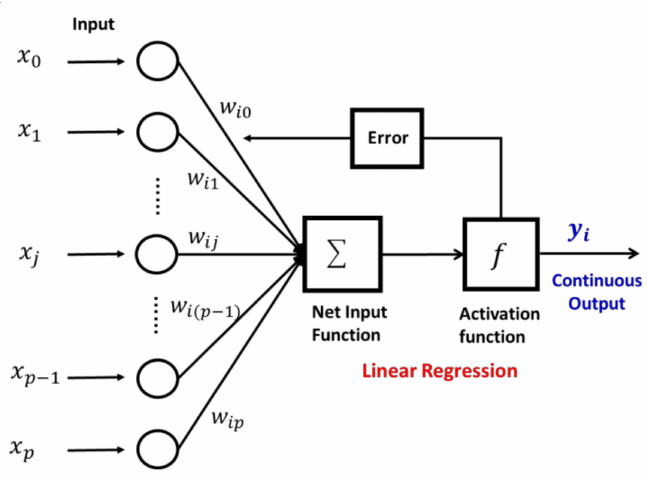
Figure 4. Demonstration of linear regression’s learning